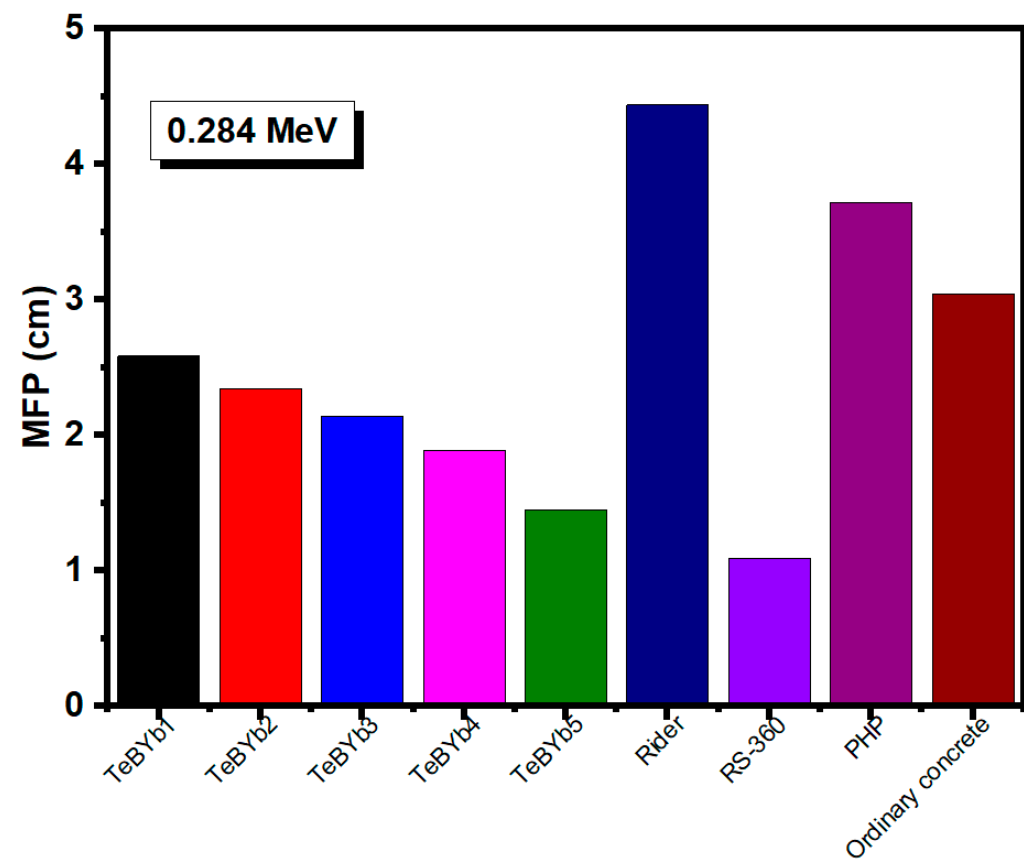
Figure 10. Comparison between the mean free path for the TeBYbX samples with some shielding materials at 0.284 MeV.